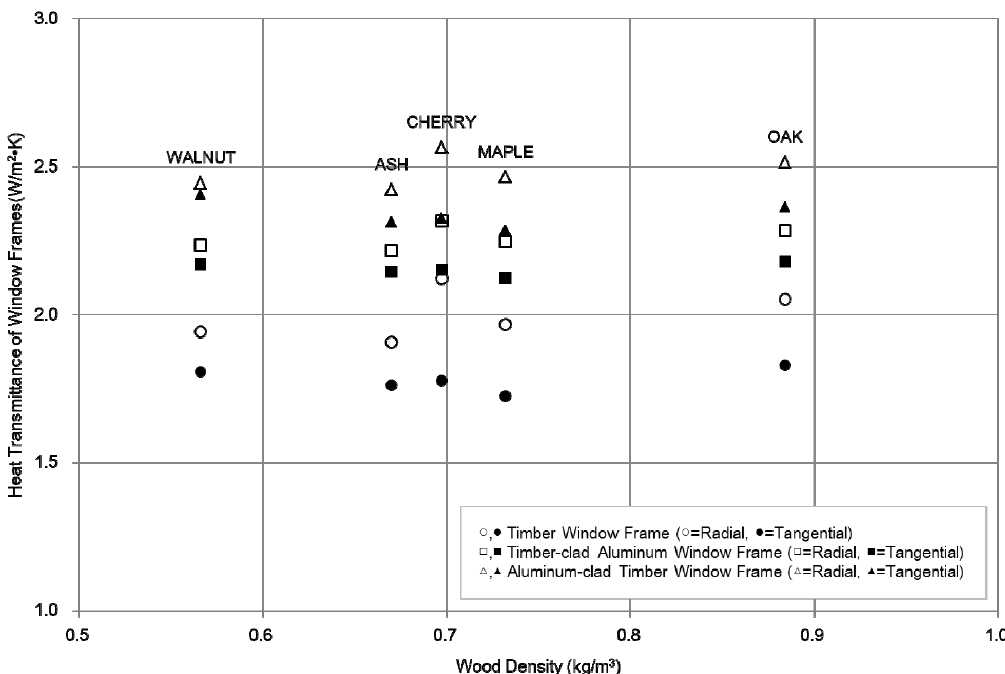
Figure 6. U-value of window frames with different wood species and anatomical direction.